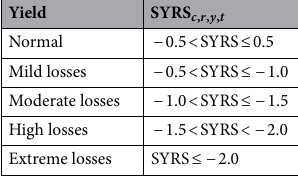
Table 2. SYRS classification 86 .